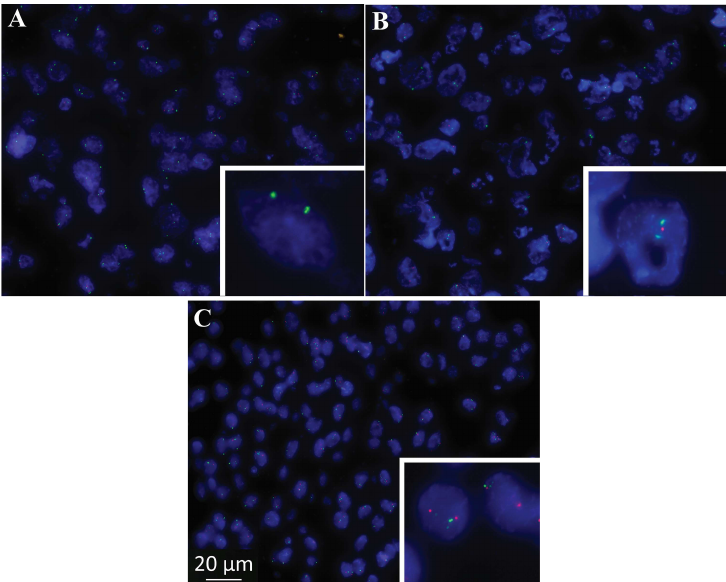
Figure 2. Representative example of Fluorescence In situ Hybridization (FISH) to visualise method of CDKN2A deletion in MPM samples. Images depict ( A ) homozygous, ( B ) heterozygous and ( C ) no loss of CDKN2A in MPM. The bottom-right corner of each image shows CDNK2A (red) as well as control CEP9 (green) signals. Images were taken using ZEISS Axio Imager M2. All pictures taken at same magnification with scale bar indicated at panel C.